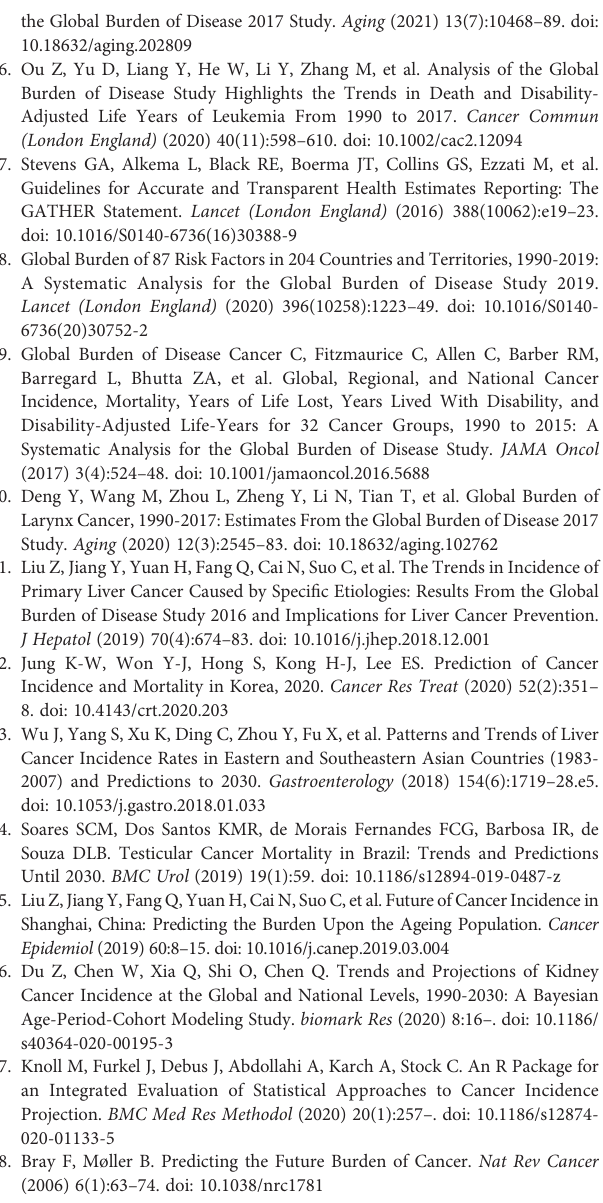
Supplementary Table S10 | The EAPCs of ASIRs of 204 countries and territories from1990 to 2019 (from high to low). ASIR: age-standardized incidence rate, EAPCs: estimated annual percentage changes, CI: con fi dence interval. Supplementary Table S11 | The EAPCs of ASDRs of 204 countries and territories from1990to2019(fromhightolow).ASDR: age-standardized deathrate, EAPCs: estimated annual percentage changes, CI: con fi dence interval. Supplementary Table S12 | TheEAPCs of age-standardized DALYRates of 204 countries and territories from1990 to 2019 (from high to low). DALY: disability- adjusted life year, EAPCs: estimated annual percentage changes, CI: con fi dence interval. Supplementary Table S13 | The age and gender distribution of incident cases and ASIRs of CLL in 2019. ASIR: age-standardized incidence rate, UI: uncertainty interval.